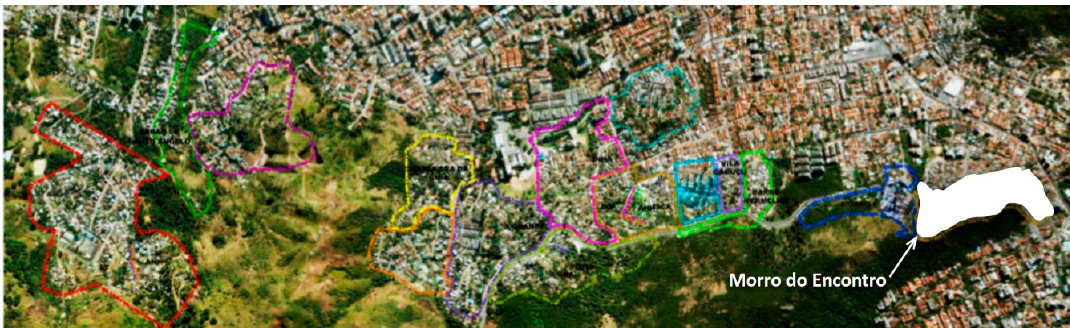
Figure 2. Scenario: general context (Lins Complex as seen from above) [45].